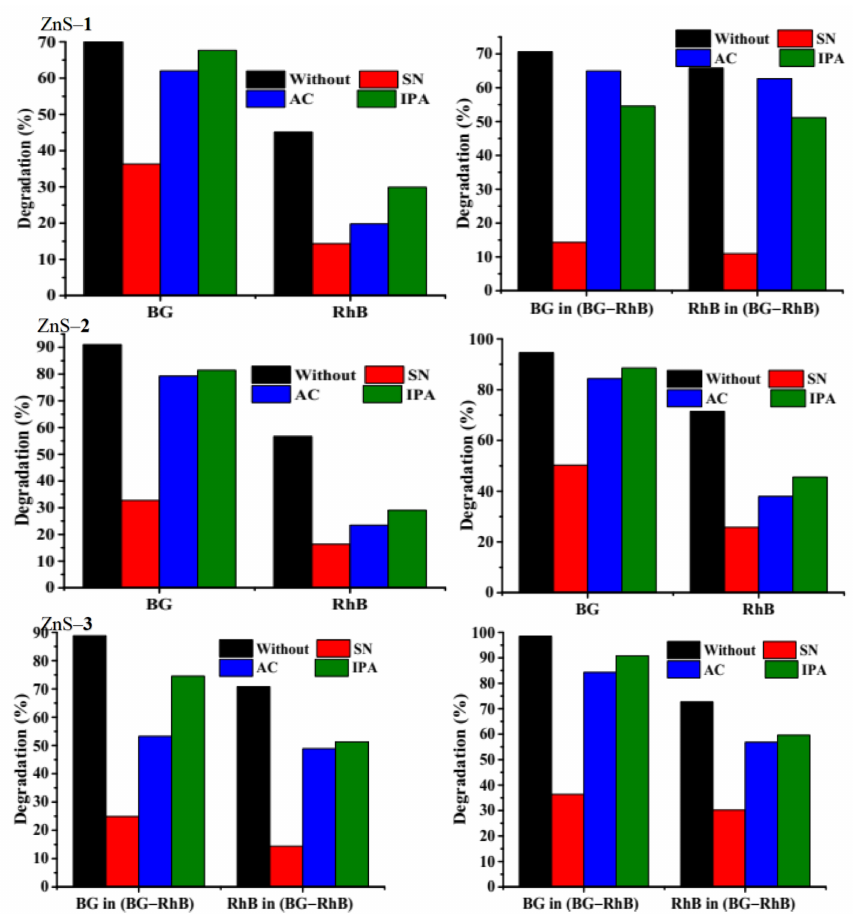
Figure 7. Effect of scavengers on single and binary dyes over ZnS quantum dots